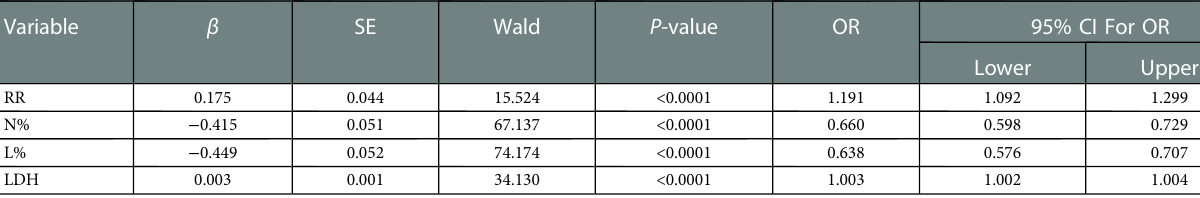
TABLE 2 Logistic regression analysis predictors of severe adenovirus pneumonia.